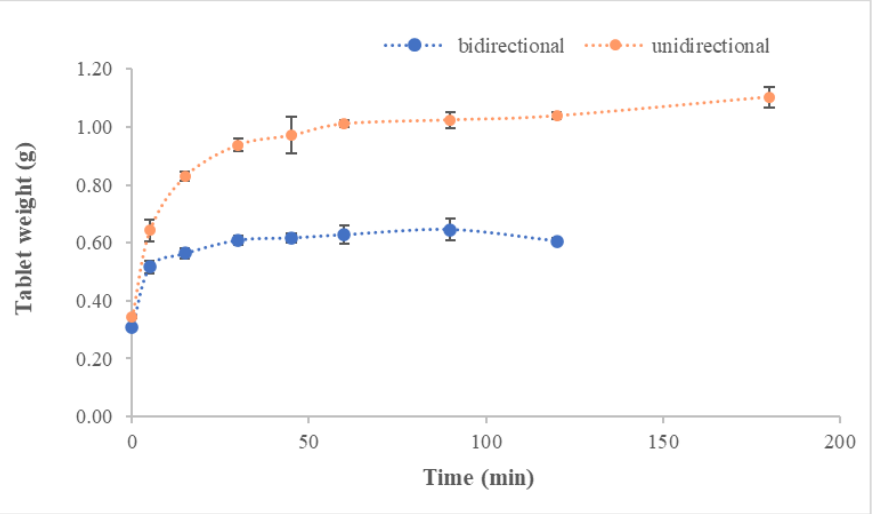
Figure 9. Swelling profiles obtained from unidirectional and bidirectional round tablets. n = 3.